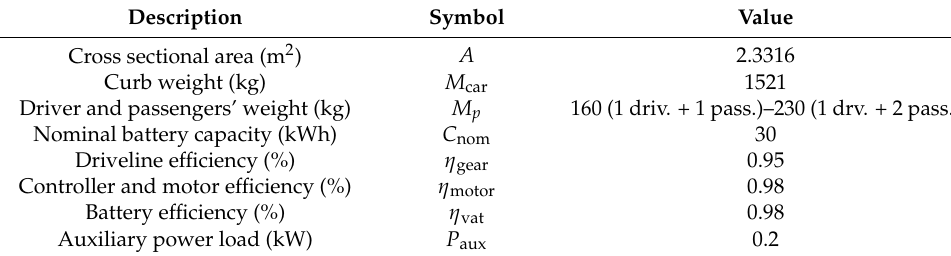
Table 1. Vehicle